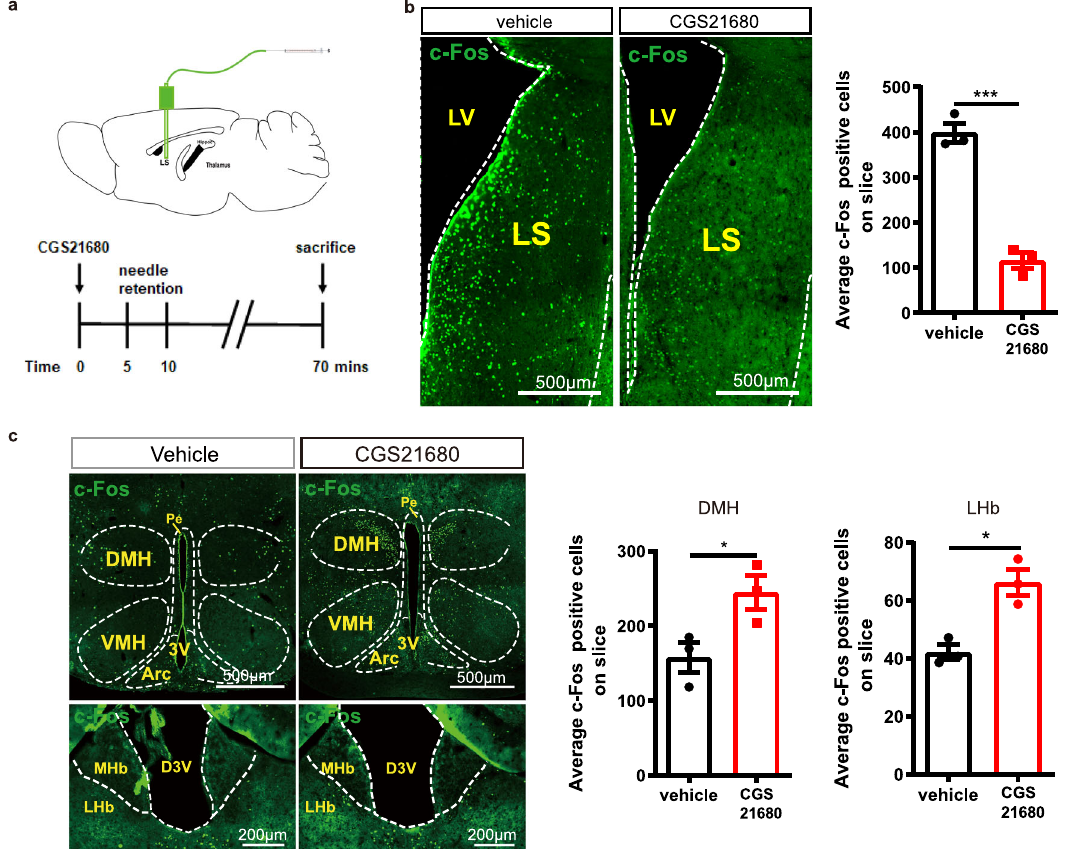
Fig.3|TheinjectionoftheA 2A RagonistCGS21680intothelateralseptum(LS) suppresses c-Fos expression in the LS and increases c-Fos expression in the lateral habenula (LHb) and dorsomedial hypothalamus (DMH). a Schematic protocol to test the role of the A 2A R agonist CGS21680 on LS outputs. b Representative immuno fl uorescence images and average bar graph illustrating the decreased expression of c-Fos in the LS ( n =3 mice/group, 9 slices/mouse, Unpaired t test, p =0.0005, t(4)=10.38). Scale bar: 500 μ m. LV, lateral ventricle. c Representative immuno fl uorescence images and average bar graphs